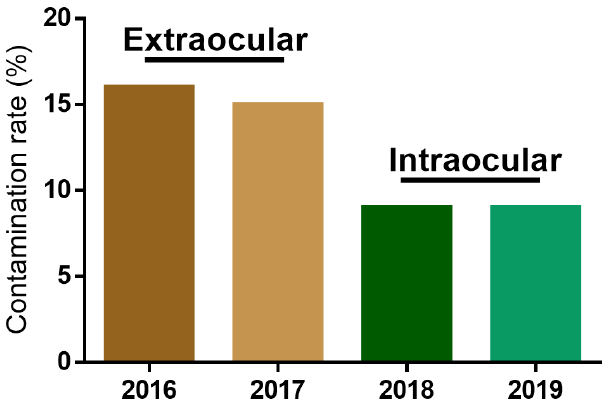
Figure 1. Corneal graft contamination rates in 2016–2019. Microbial sampling was performed at the extraocular side of the corneoscleral rim from 2016 to 2017 and at the intraocular side of the corneoscleral rim from 2018 to 2019. The corneal graft contamination rates were: 16.15% in 2016, 14.87% in 2017, 7.96% in 2018, and 8.63% in 2019.